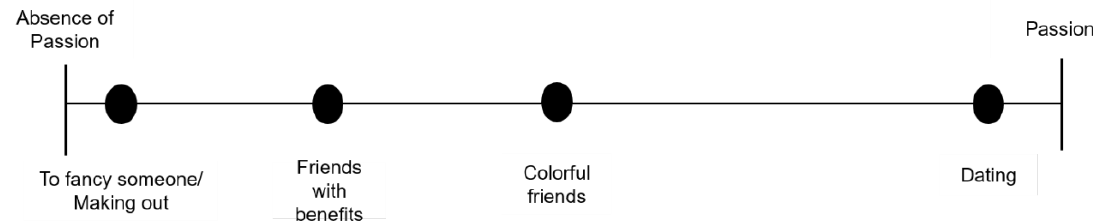
Figure 3. Spectrum of the representation of passion in love relationships between adolescents.